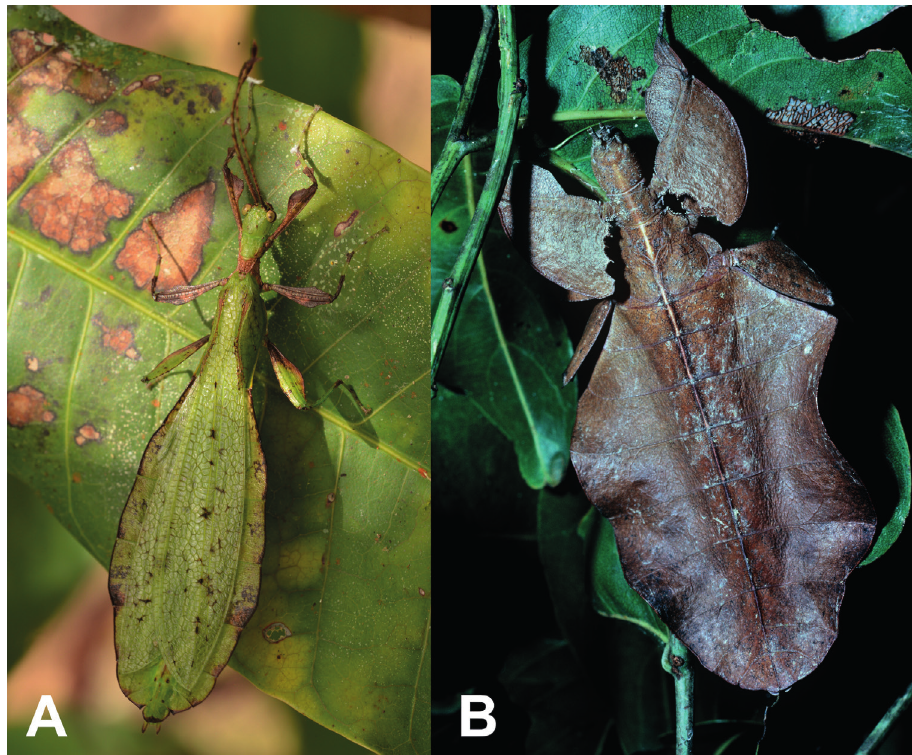
Figure 1. Live representatives from two of the three herein described genera A Rakaphyllium schultzei comb. nov. male photographed by Loïc Degen (Switzerland) on Wokam Island, Aru Islands, Indonesia B Acentetaphyllium brevipenne comb. nov. brown form female, photograph purchased from Alamy stock photo website, noted as simply from the “rainforest of New Guinea”, no additional observational data could be